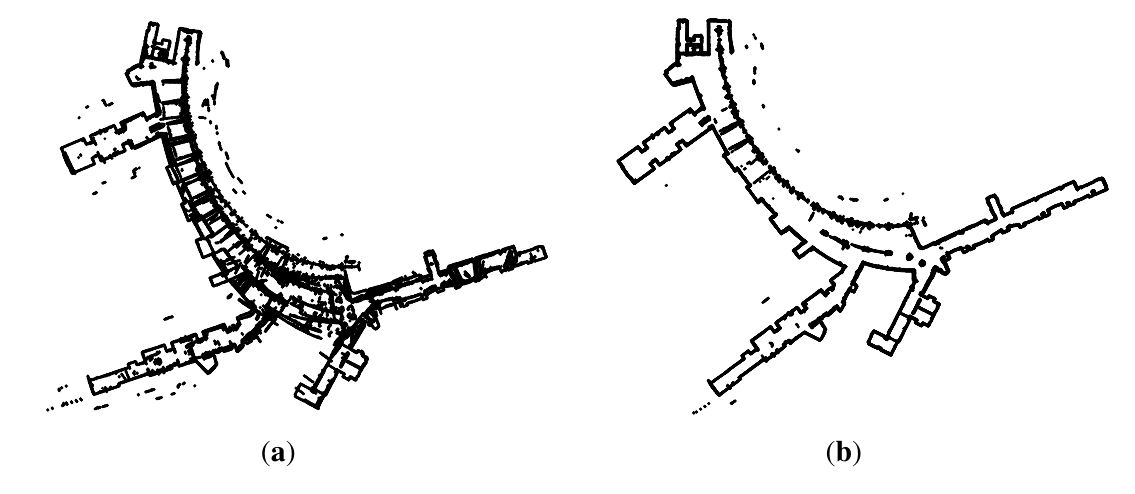
Figure 7. An example result of applying the Rao-Blackwellized particle filtering algorithm to the generated submaps. ( a ) The map generated using only odometry. ( b ) The map resulting from the RBPF using 100 particles at a resolution of 10